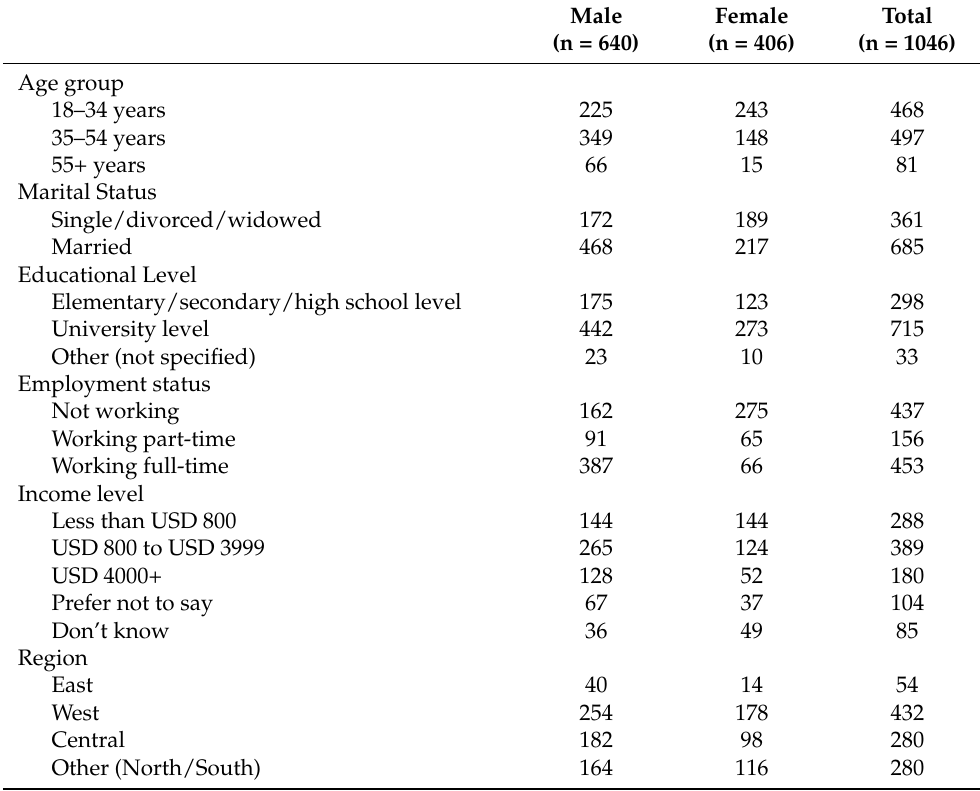
Table 1. Sociodemographic